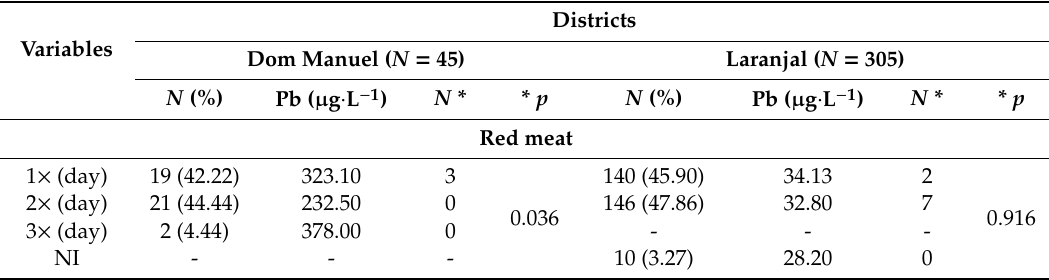
Table A3. Levels of blood Pb associated with the diet of individuals living in the districts of Dom Manuel and Laranjal, State of Par á , Brazil,